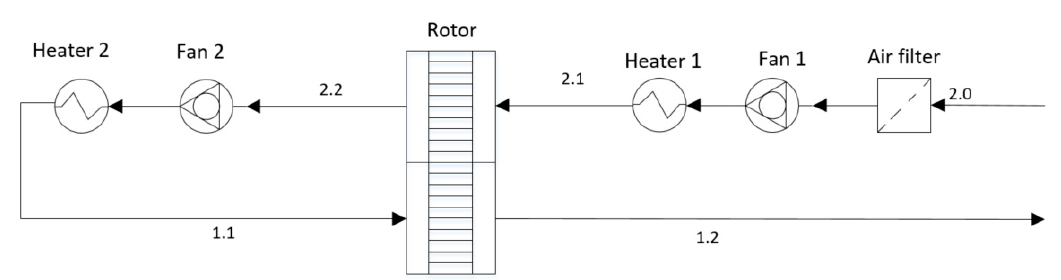
Figure 7. Pilot plant set-up scheme.